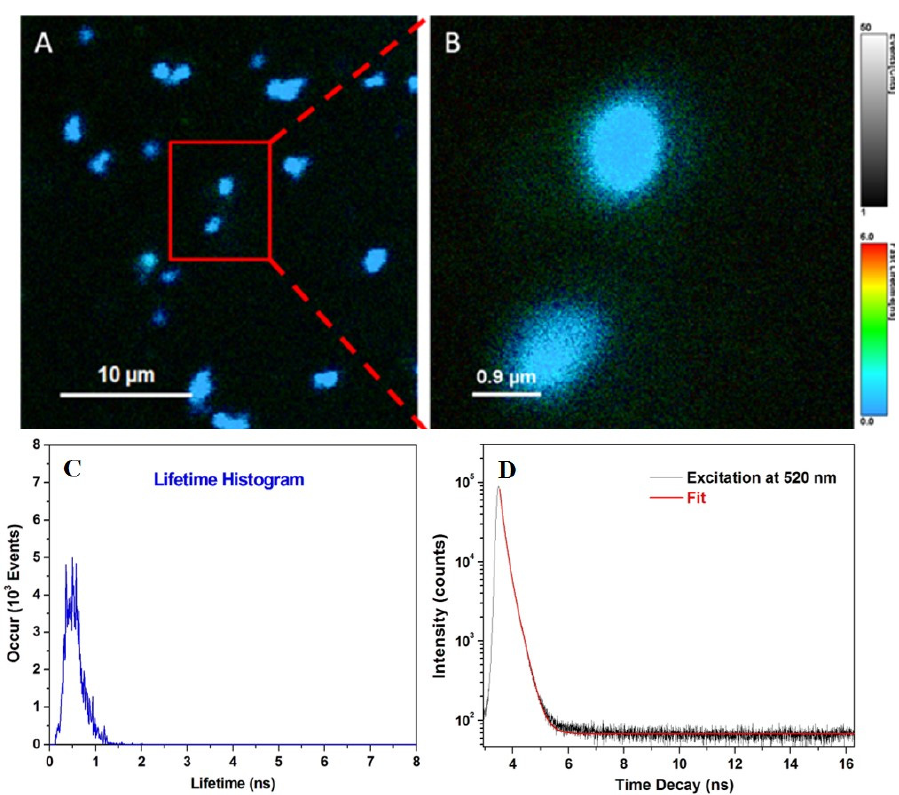
Figure 4. Confocal FLIM images ( A , B ) and respective fluorescence lifetime histogram corresponding to FLIM image from B; ( C ) and fluorescence lifetime decay of CaCO 3 (PAH)@RBITC@AN microcapsules dropped on a microscope substrate. Excitation wavelength: 520 nm ( D ).